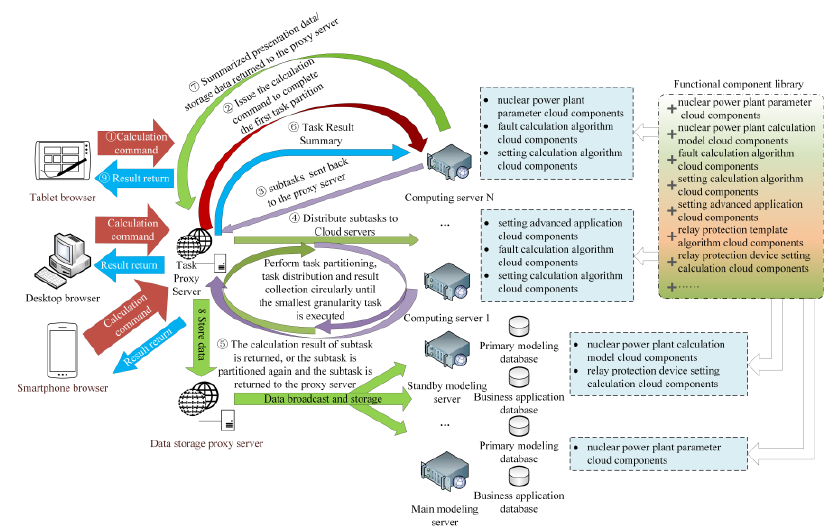
Figure 3. Cloud setting computing task processing topology diagram.